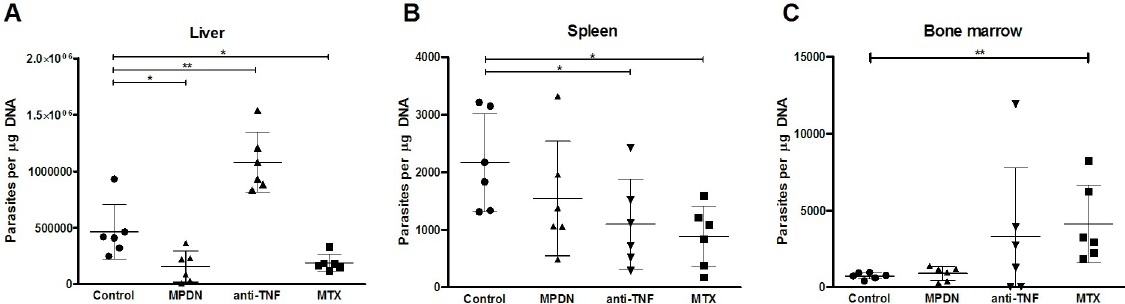
Fig 1. Parasite loads in the organs of L . infantum -infected mice treated with the different immunosuppressants. C57BL/6 mice (6 animals per group) were treated with PBS (control), MPDN (methylprednisolone), anti-tumour necrosis factor antibodies (anti-TNF) or MTX (methotrexate) one week before infection with 1x10 7 L . infantum promastigotes. All animals were euthanized four weeks after infection and number of parasites per μ g of DNA of liver (A), spleen (B) and bone marrow (C) were determined by qPCR. Results for each animal are shown, as well as the mean ± standard deviation per group. � p < 0.05, �� p <